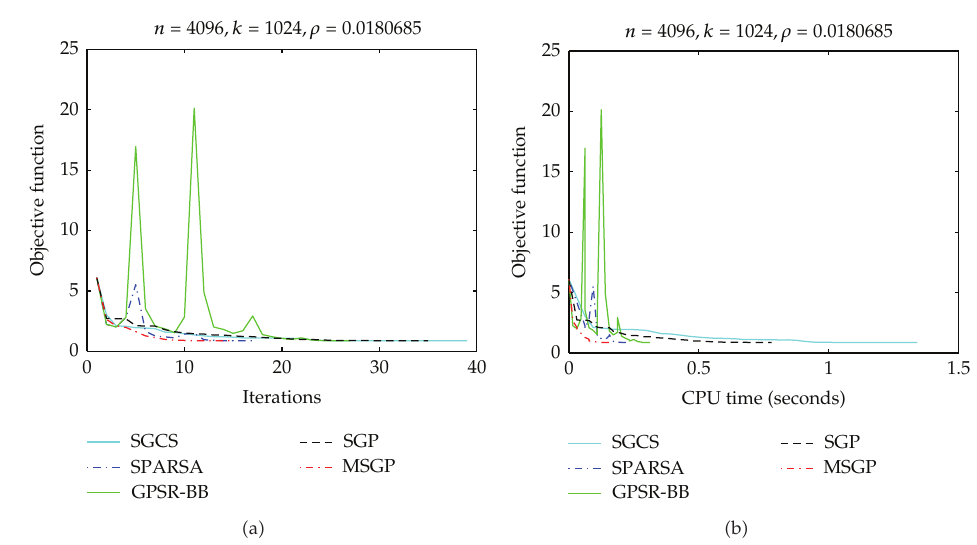
Figure 2: The objective function plotted against iteration number and CPU time for SGCS, SPARSA, GPSR- BB, SGP, and